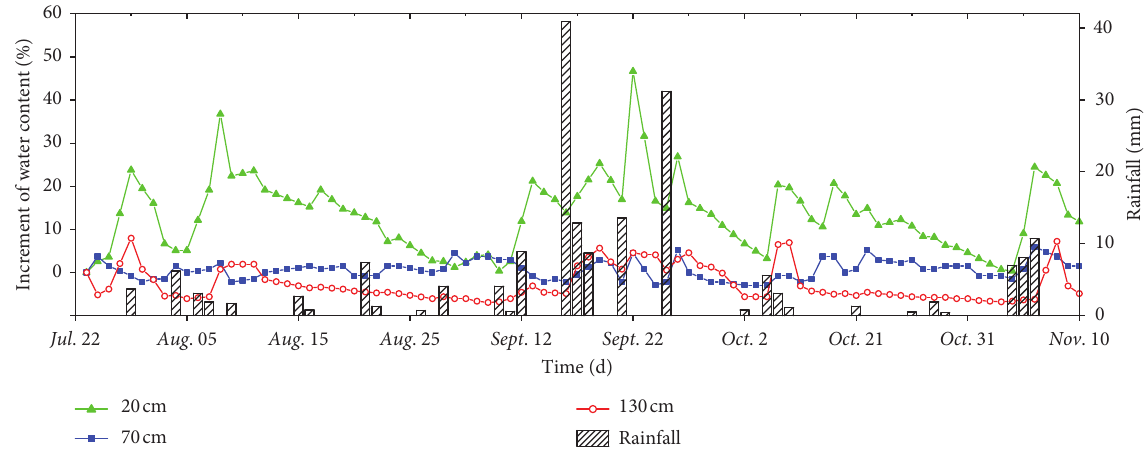
Figure 5: Time history curve of slope depth at different depths (slope